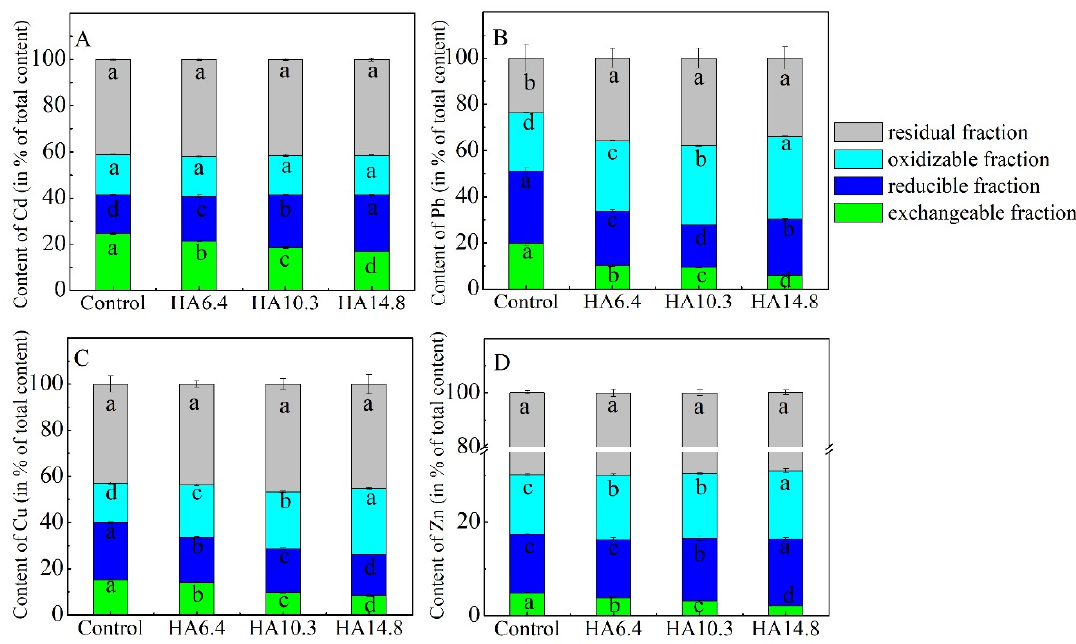
Figure 2. The chemical fractions of Cd (A), Pb (B), Cu (C), and Zn (D) in soil after harvest of tobacco. Data are means ± SD ( n = 4) and bars represent standard errors. Lowercase letters represent significant differences at the 0.05 level between different treatments at the same fraction.